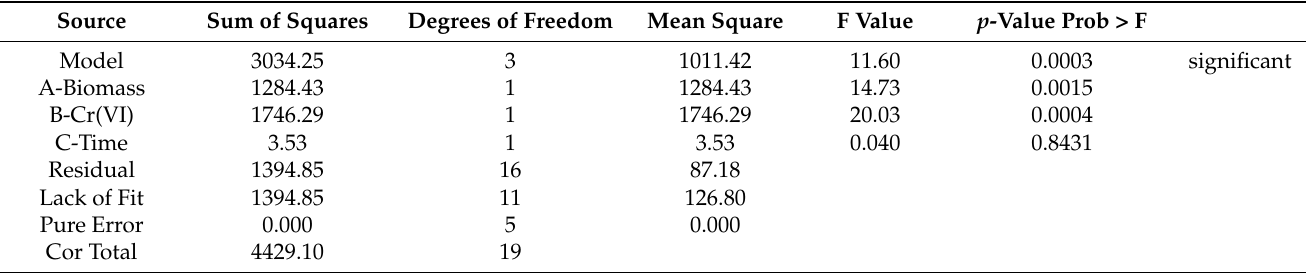
Table 6. ANOVA of sorption capacity q with the linear model of Equation (8).